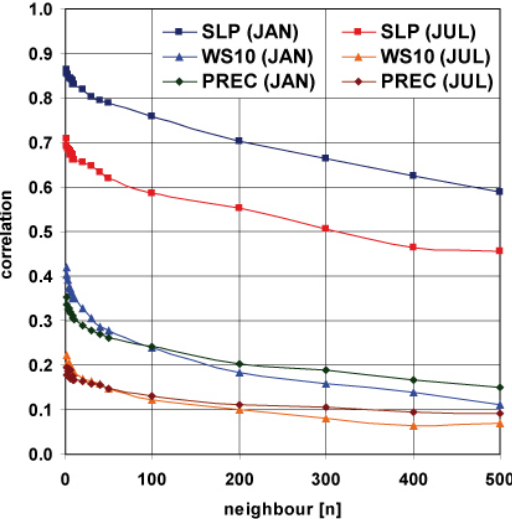
Fig. 4. Density of suitable analogs for HiResAFF estimated as the decay in daily mean field correlation as a function of n next neigh- bours instead of the best analog chosen from around 4500 possible analogs. Displayed are the variables of SLP, wind speed (WS) and PREC for January and